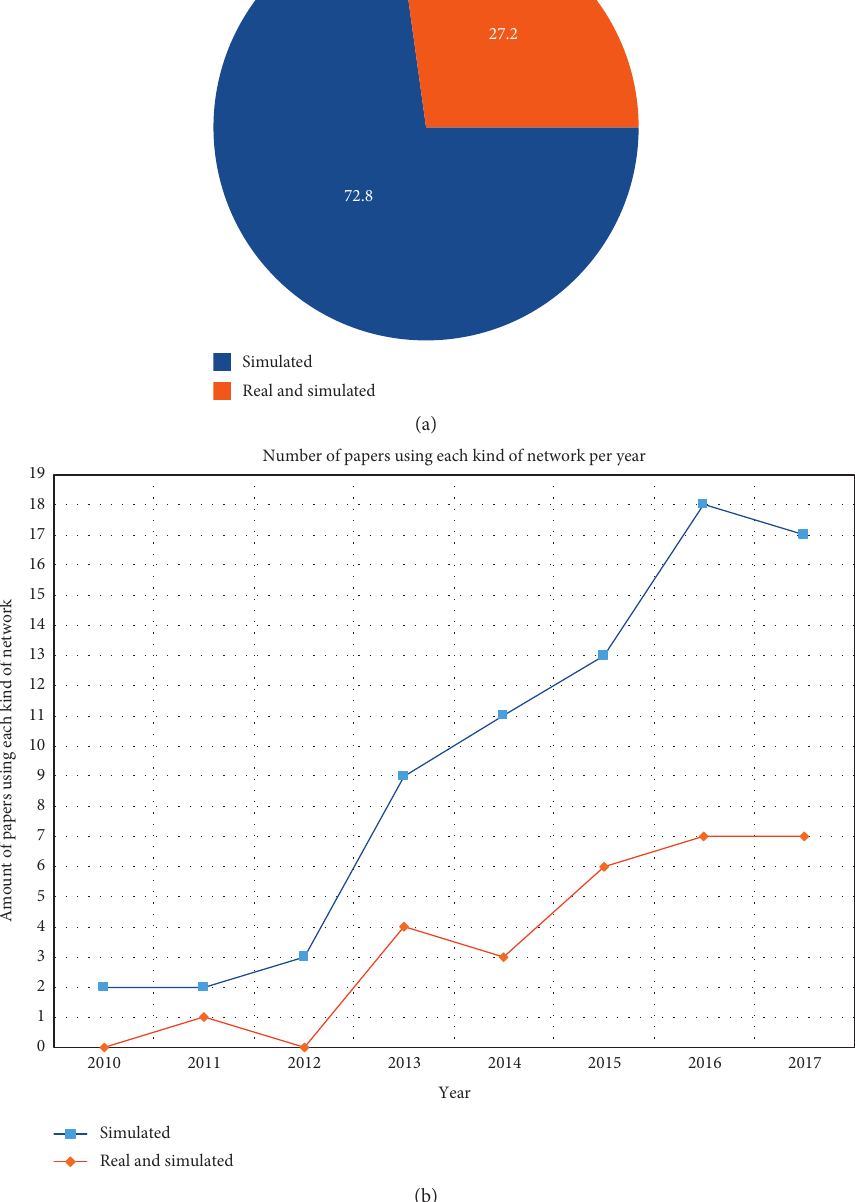
Figure 5: Type of networks to test the framework among the articles reviewed. (a) Percentage of papers using each type of networks to test the framework. (b) Amount of papers per year using each type of networks to test the